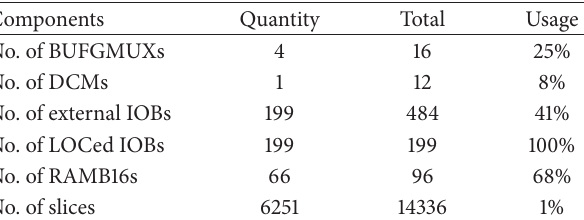
Table 14: Other components utilized by